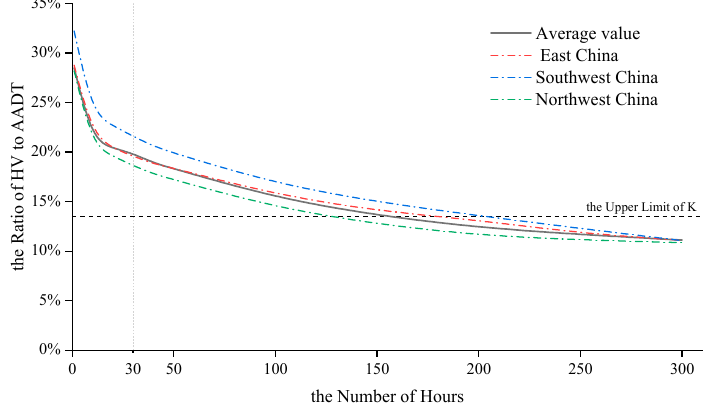
Figure 5. Relationship between the number of peak hours and HV-to-AADT ratio.